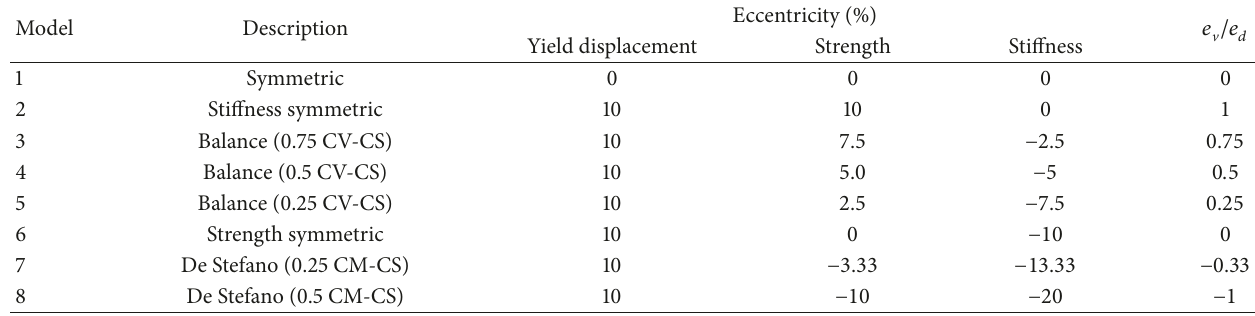
Table 2: Eccentricity of asymmetric buildings.